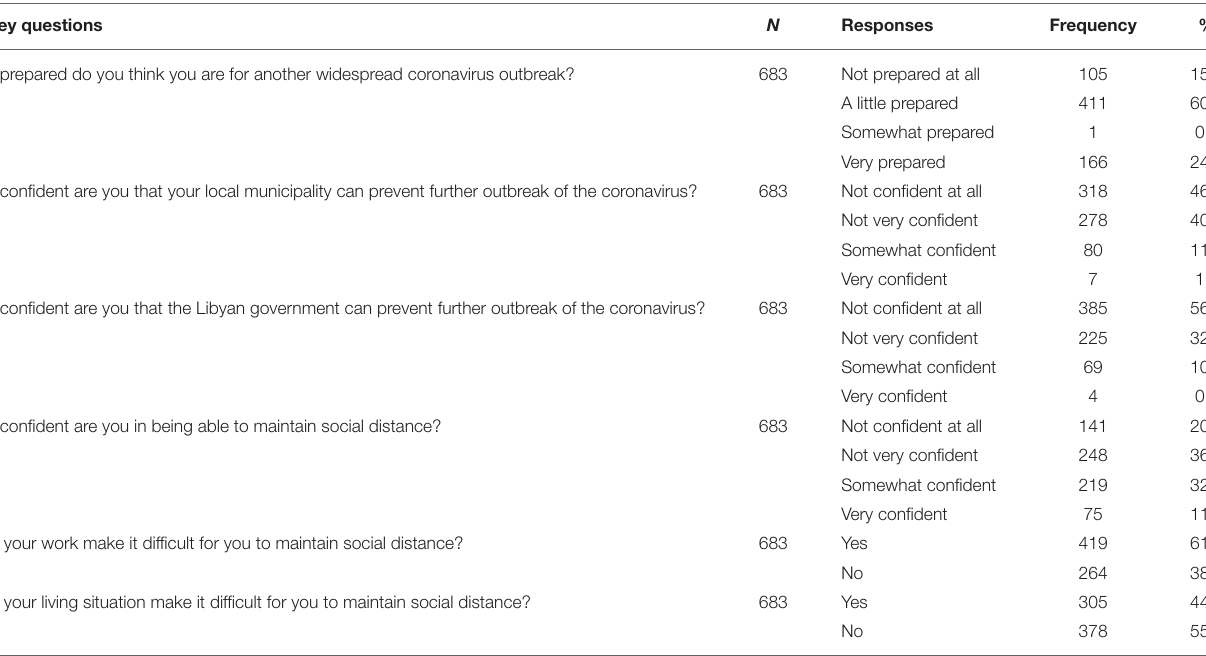
TABLE 8 | Preparedness for COVID-19 outbreak ( N =